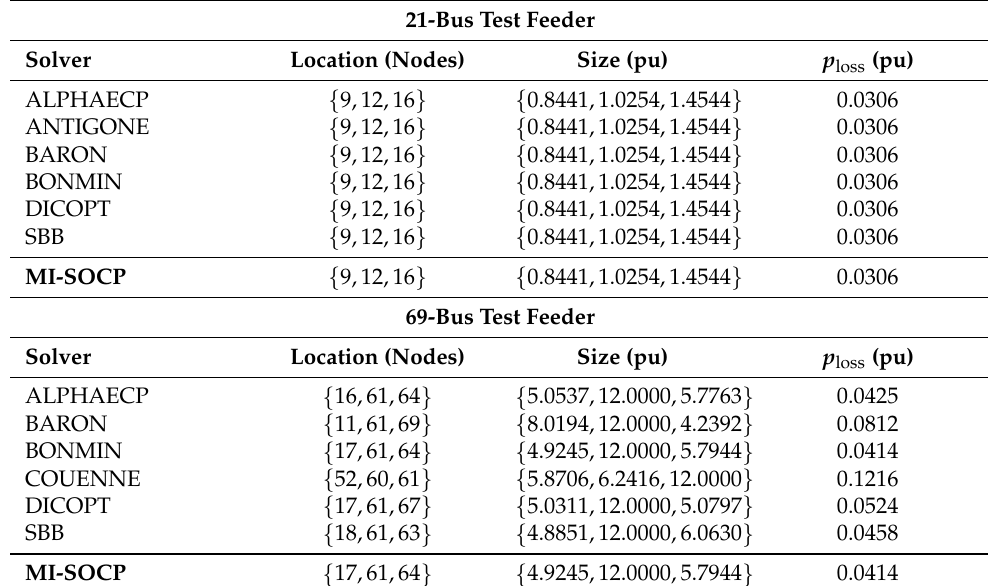
Table 3. Comparative results between the proposed MI-SOCP approach and the GAMS package. 21-Bus Test